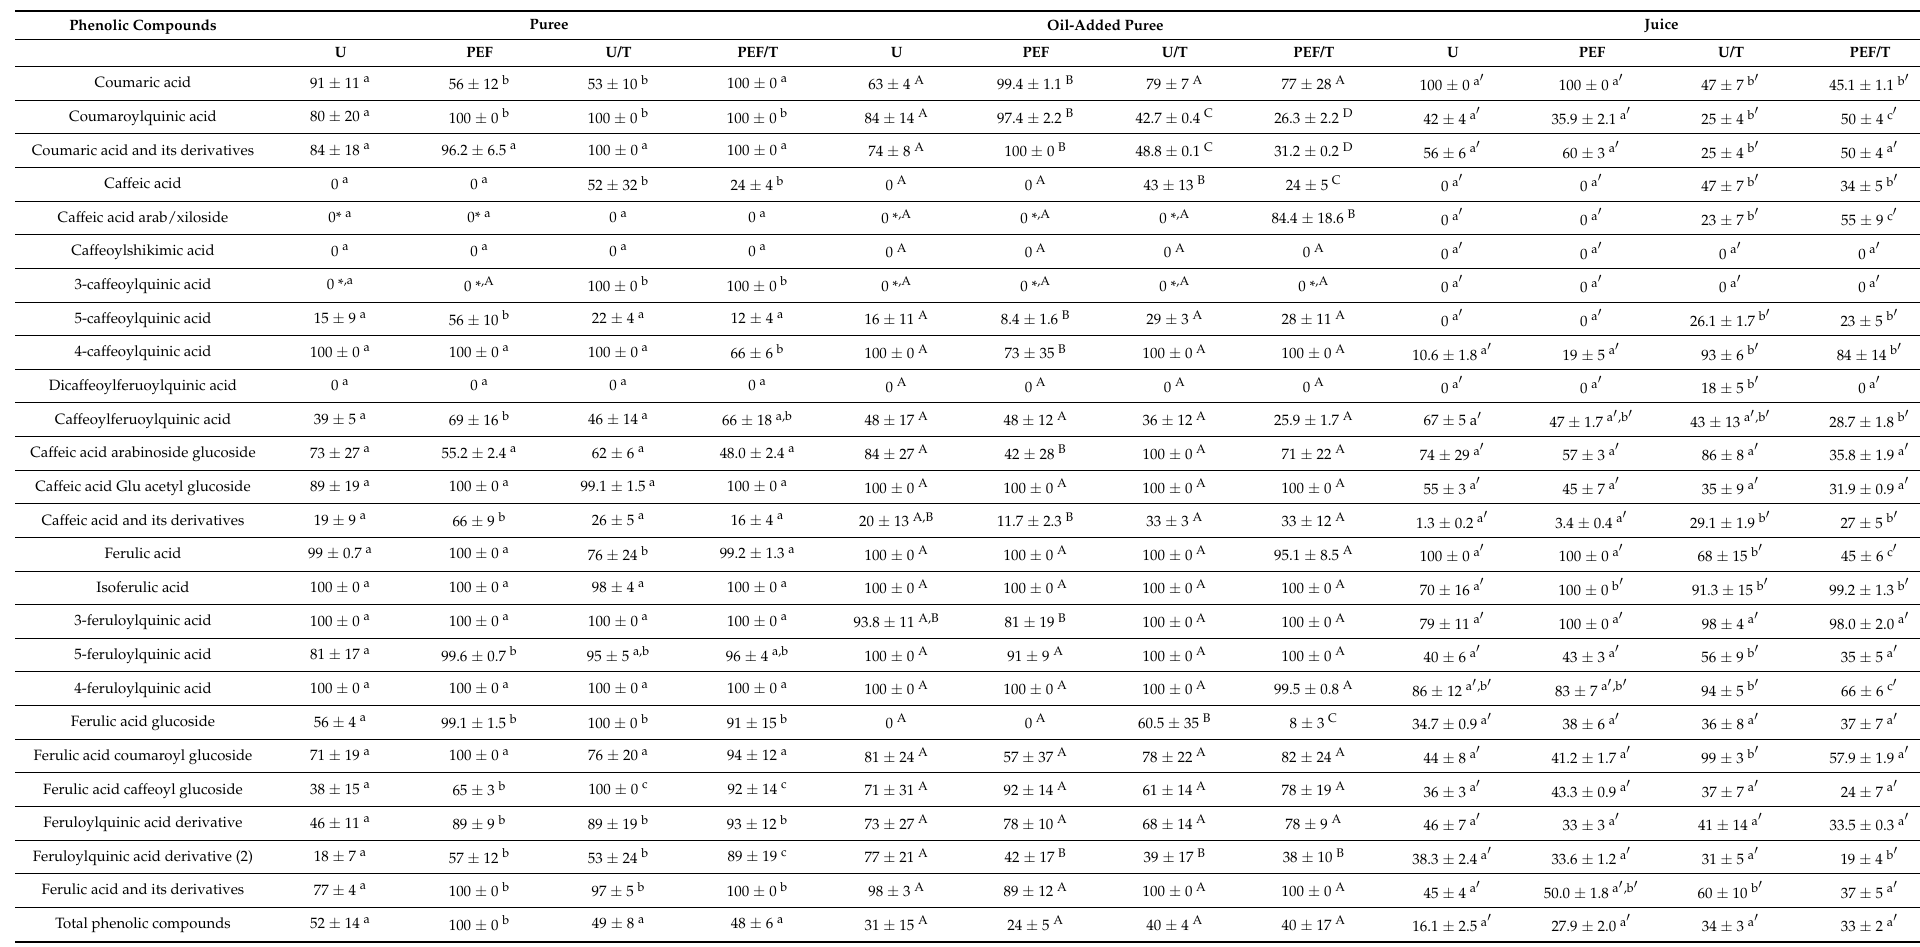
Table 4. Phenolic bioaccessibility of untreated purees and juices (U), those obtained from PEF-treated (0.61 kJ kg − 1 ) carrots (PEF), and those thermally treated (10 min at 70 ◦ C) (U/T and